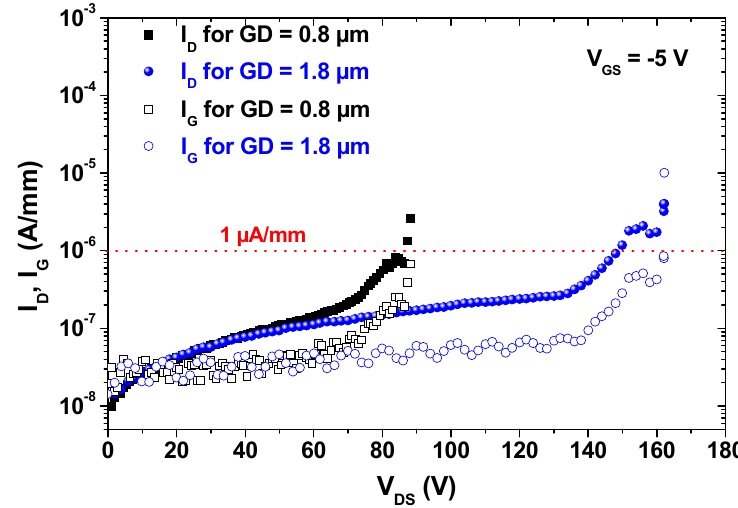
Figure 3. Off-state characteristics and gate leakage current at V GS = − 5 V of the 2 × 25 µm AlN/GaN-on-Si HEMTs for gate-drain distances of 0.8 µm (black squares) and 1.8 µm (blue circles).